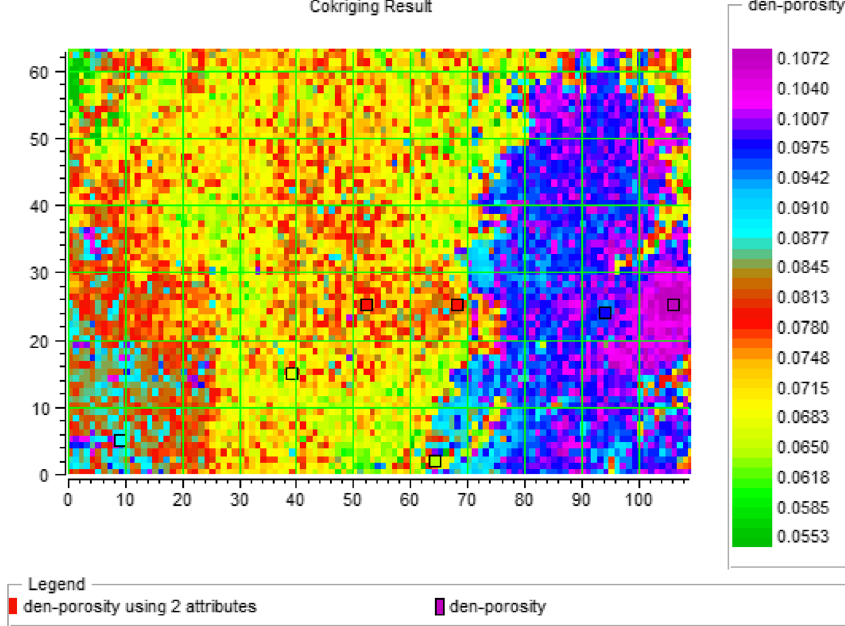
Fig. 35 Result of geostatisti- cal estimation of porosity on the one page for the second category of